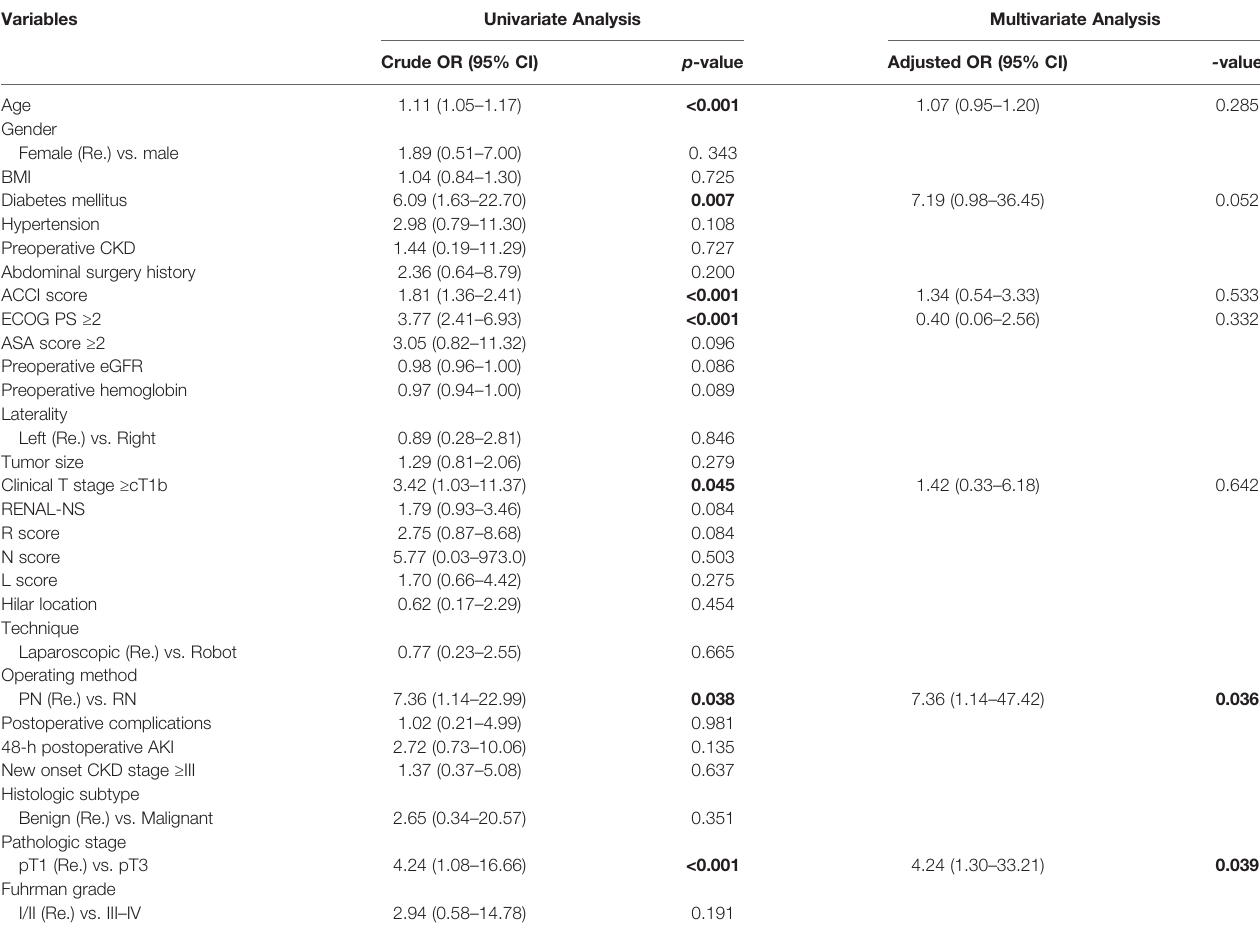
TABLE 6 | Univariate and multivariate Cox analysis of independent risk factors for overall